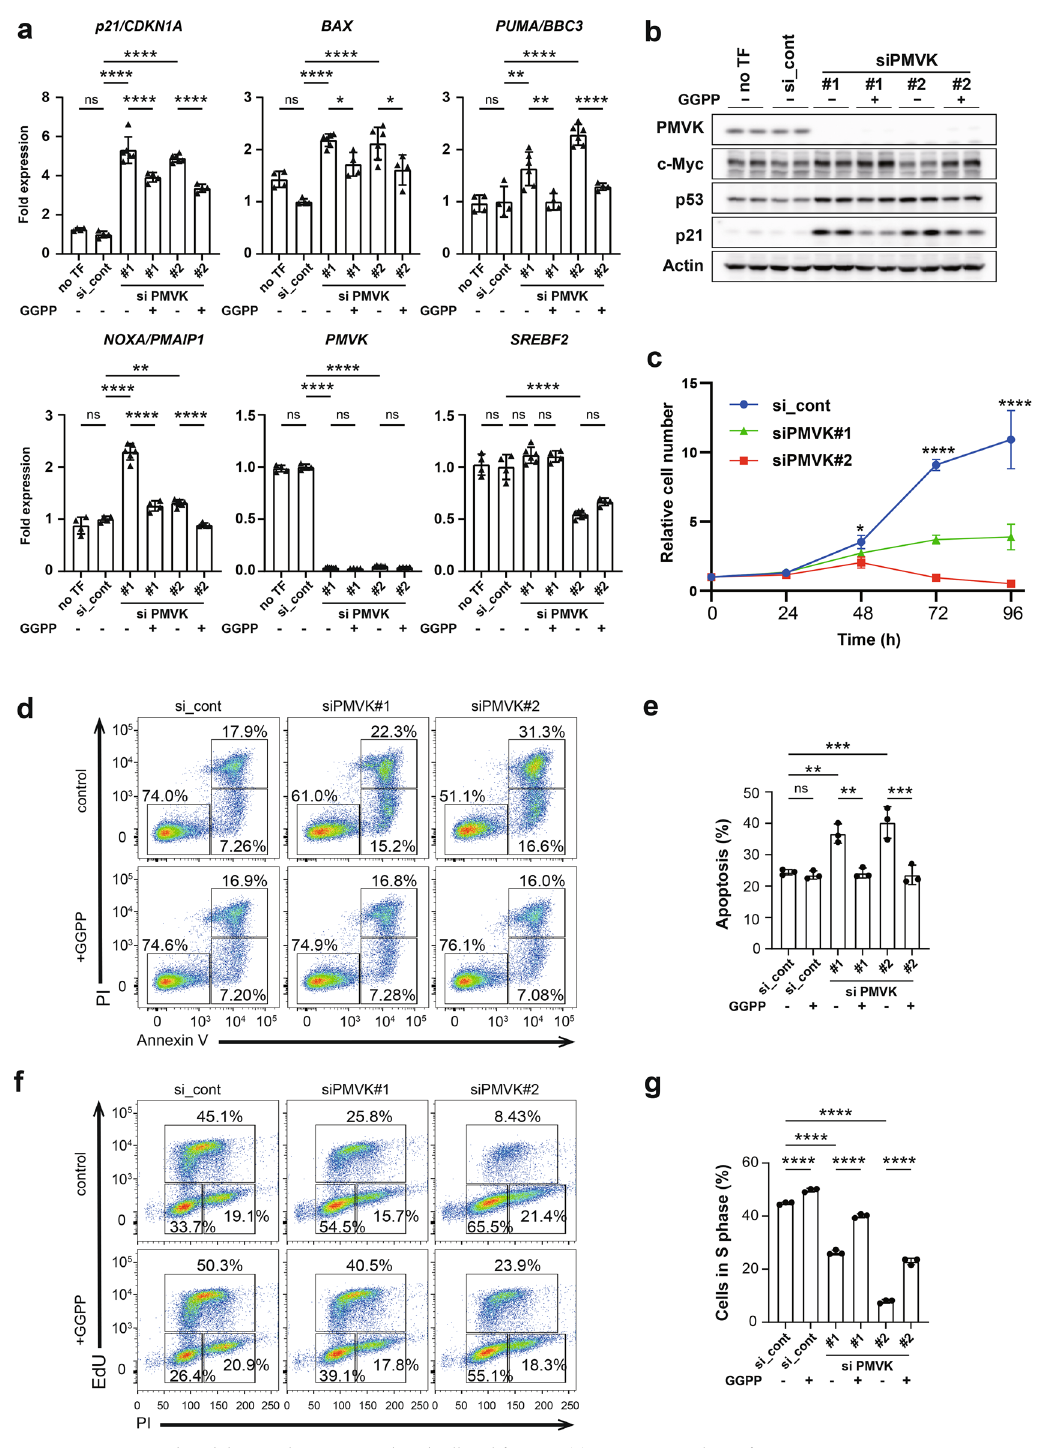
Figure 6. PMVK knockdown induces p53-mediated cell proliferation. ( a ) qRT ‒ PCR analysis of PMVK , p21/CDKN1A, BAX , NOXA , PUMA, and SREBF2 in MCF-7 cells transfected with control or PMVK siRNAs and treated with or without geranylgeranyl pyrophosphate (GGPP) for 60 h (n = 4 or 6, mean ± SD, *p < 0.05, **p < 0.01, ****p < 0.0001 by one-way ANOVA). ( b ) Western blotting for PMVK, c-Myc, p53, p21/CDKN1A, and actin in MCF-7 cells transfected with control or PMVK siRNAs for 48 h. ( c ) p53 WT MCF-7 cells were transfected with control or PMVK siRNAs and subjected to a cell proliferation assay. Error bars represent the SD of the mean (n = 4, *p < 0.05, ****p < 0.0001 by one-way ANOVA). ( d ) MCF-7 cells were transfected with control or PMVK siRNAs for 64 h. The effect of PMVK knockdown on cell apoptosis was detected via annexin V-633/PI double staining of MCF-7 cells and flow cytometry assessment. Representative images are shown. ( e ) The percentages of annexin V-633-positive/PI-negative cells (lower right, early apoptosis) and annexin V-633-positive/PI-positive cells (upper right, late apoptosis) were quantified. (n = 3, **p < 0.01, ***p < 0.001 by one-way ANOVA). ( f ) MCF-7 cells were transfected with control or PMVK siRNA, treated with geranylgeranyl pyrophosphate (GGPP) for 48 h and subjected to an EdU assay with flow cytometry analysis. For the control sample, 70% methanol was added. Representative images are shown. ( g ) The proportion of cells in the S phase was quantitated and plotted (n = 3). Error bars represent the SDs of the means. ****p < 0.0001 (one-way